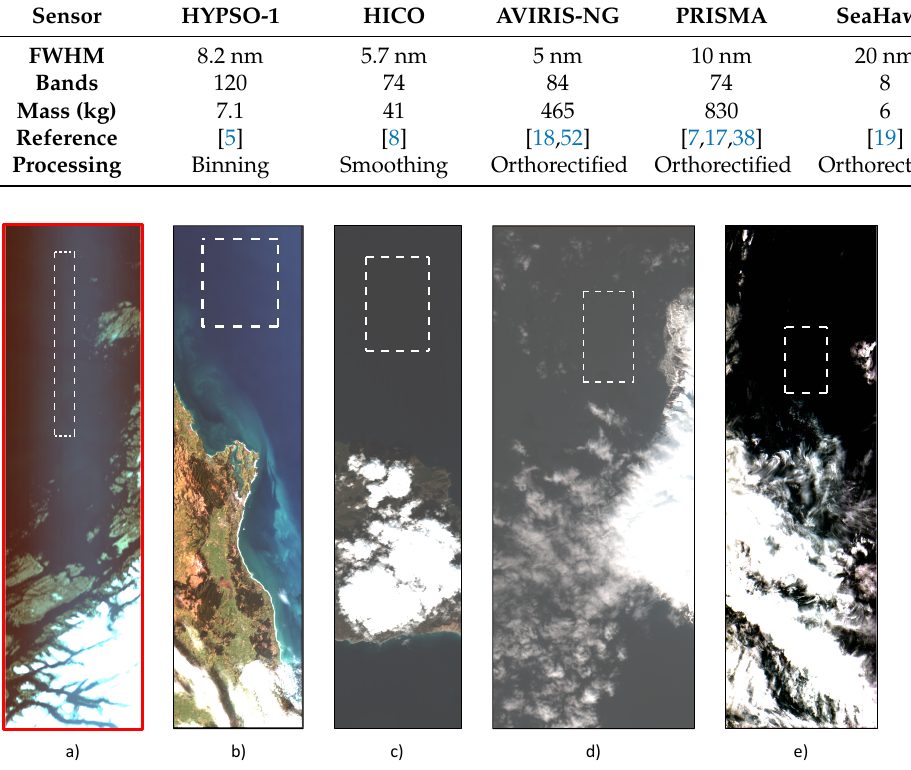
Figure 14. RGB renders of the data sets used for SNR estimation. The square dashed white boxes mark the regions that estimate SNR. See Table 9 for details. The RGB renders are cropped and scaled to spatially have a similar aspect ratio. The bands used for the RGB composite representation are the ones closest to 602.5 nm, 565 nm, and 498.4 nm, respectively, for the given sensor. The distribution of the signals are given in Figure 15.